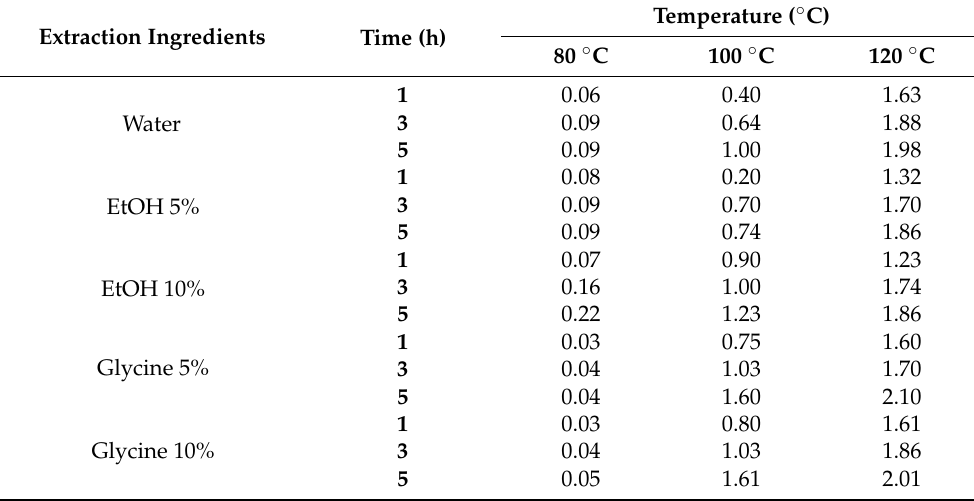
Table 1. Comparison of SS extraction concentration (wt.%) by various extraction ingredients, temper- ature, and